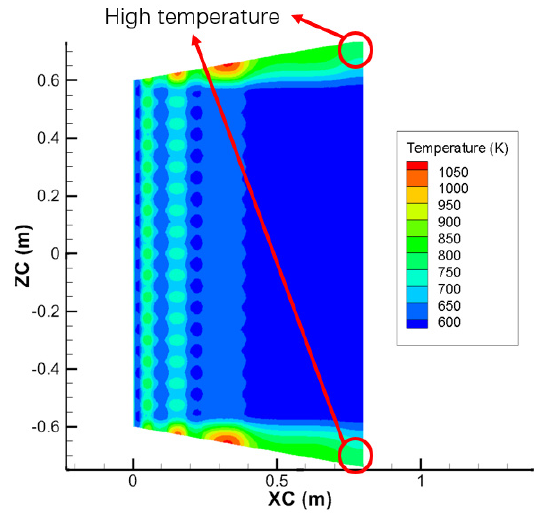
Figure 7. The temperature contour of XC–ZC cross-section.